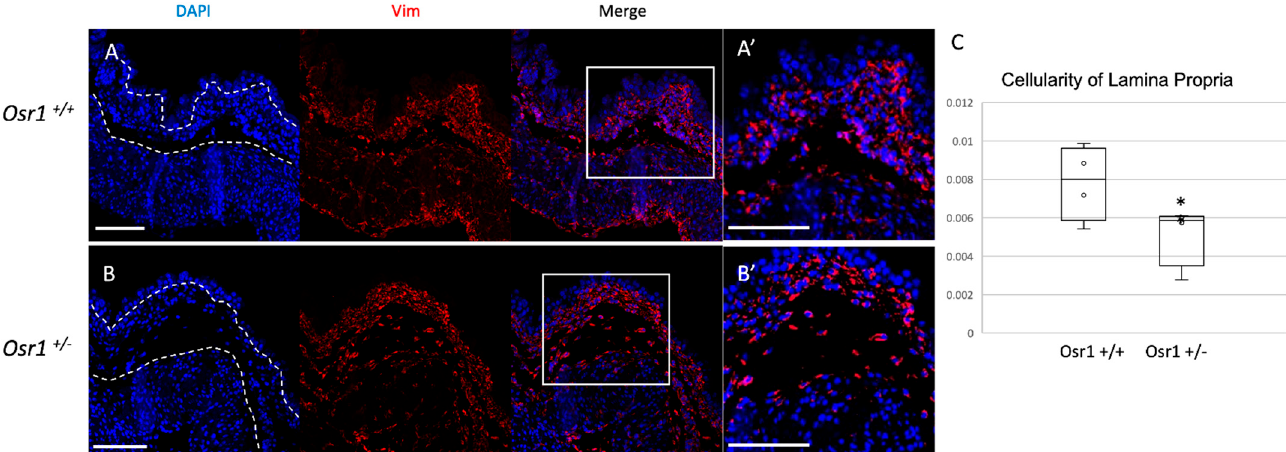
Figure 2. Osr1 +/ − newborn mice have a decreased number of cells in the lamina propria: Immunofluorescent staining for Vimentin protein (red) and DAPI (blue) shows more Vimentin-positive cells in the lamina propria of the Osr1 +/+ mouse bladder ( A , A’ ) compared to Osr1 +/ − ( B , B’ ). White boxes indicate magnified region in A’ and B’. ( C ) Cellularity was quantified by counting Vimentin-positive cells normalized to total lamina propria area in each section, asterisk (*) indicates p < 0.05. Scale bar = 100 µ m ( n = 4 mice/genotype, two to three sections per mouse were examined). Dotted lines delineate lamina propria.